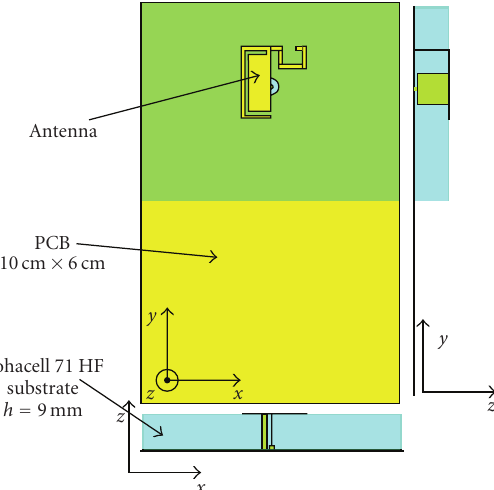
Figure 1: Top and side views of the tri-band antenna.